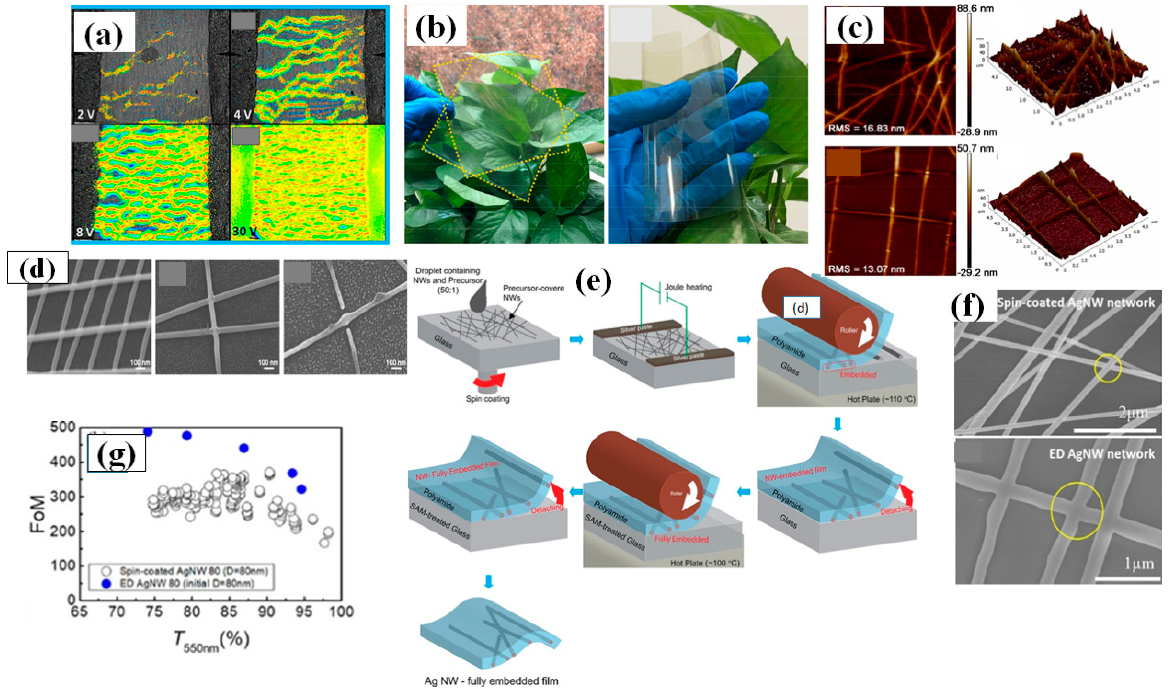
Figure 21. ( a ) Image shows the phase signal resulting from all the IR radiations collected during the 5 min cycles at a given voltage (2 V, 4 V, 8 V, 30 V) (adapted from [237] with permission from ACS publications, 2016). ( b ) Images of two stacked sheets of AgNW flexible electrodes and a sheet of AgNW flexible electrode which is folded through at 180°. ( c ) AFM images of a pristine AgNW network and regularly arranged AgNW network. The image size is 5 × 5 µm ( d ) SEM images of without treatment, with plasma treatment of 150 W for 2 min, 200 W for 5 min. (adapted from [238] with permission from Royal Society of Chemistry, 2020). ( e ) Process of transparent electrode fabrication from Ag NW mixing solution to Ag NW-fully embedded film (adapted from [239] with permission from ACS publications, 2019). ( f ) SEM images of the AgNW networks before and after electrodeposition. Electrodeposition welds the AgNWs together. ( g ) FoMs for AgNW networks with initial diameters 80 nm. The FoMs of the ED AgNW networks are superior to those of the as-spin-coated AgNW networks (adapted from [240] with permission from ACS publications, 2020).